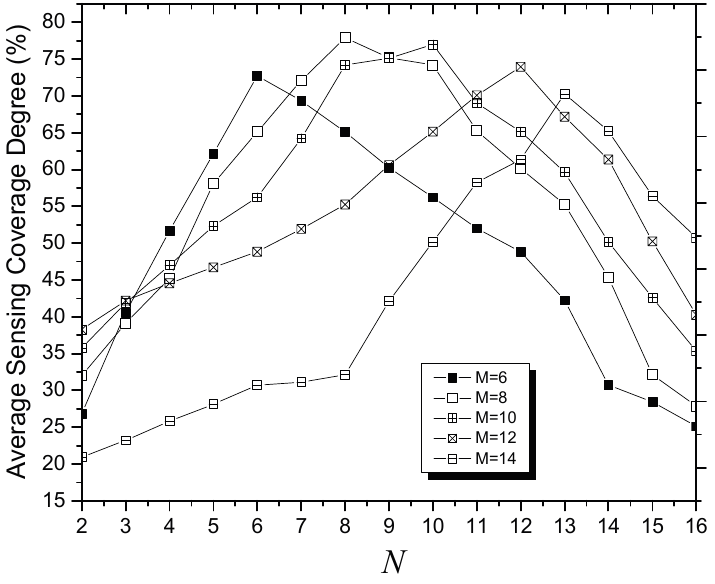
Figure 1. Average SCD versus different dividing of virtual